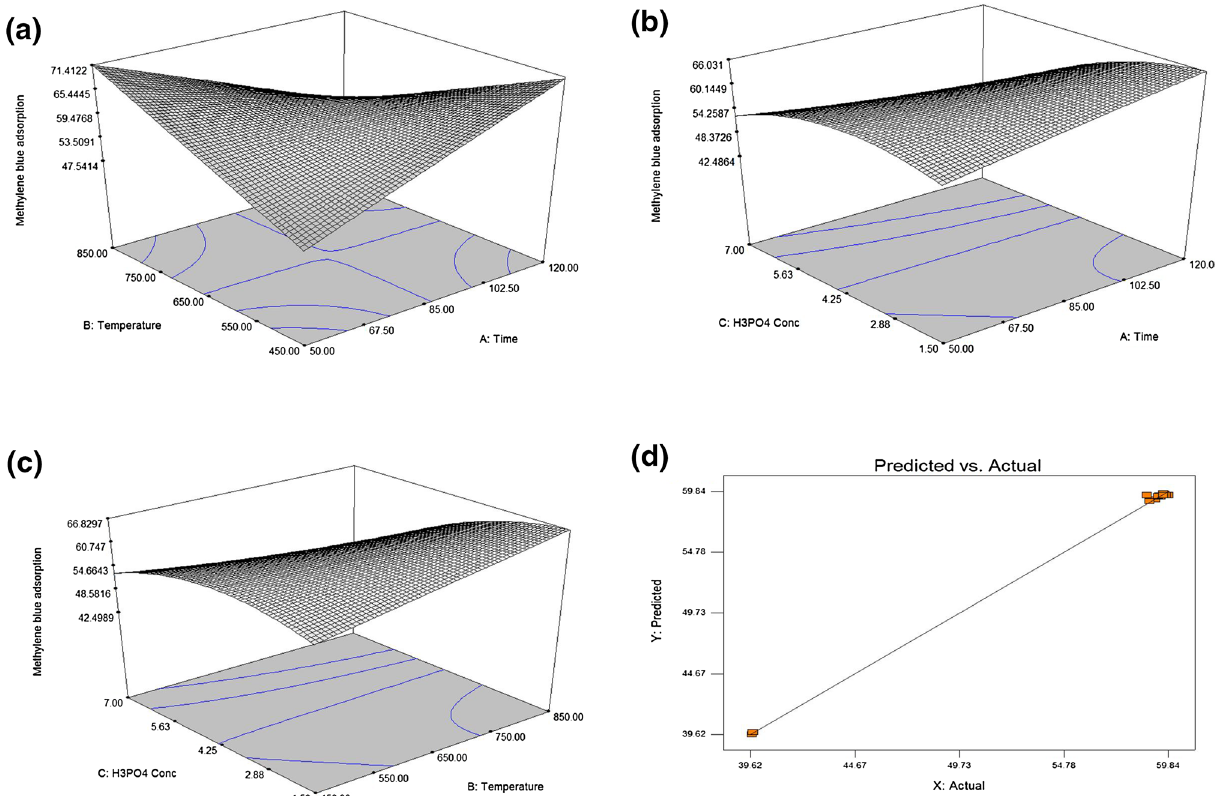
Fig. 2 3D plots of a interaction of time and temperature, b interaction of time and H concentration, d actual vs model predicted adsorption capacity